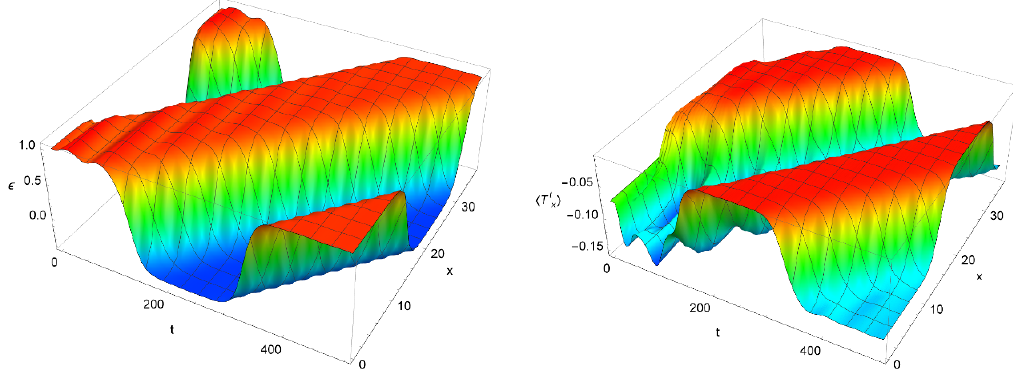
Figure 10 . Space and time dependence of the energy density (cid:15) (left) and the transferred momentum density h T t i (right). The initial state is obtained from the (cid:12)nal snapshot in (cid:12)gure 7, modi(cid:12)ed by x adding the constant C = 0 : 05 to the function ~ B ( z; x